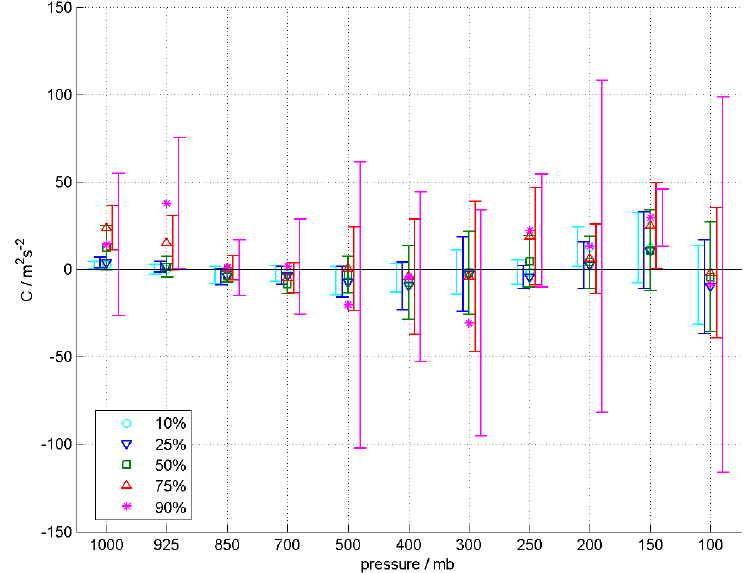
Figure 7. Results and vertical profile for the coefficient C at the five percentiles: 10%, 25%, 50%, 75%, and 90%. The error bars shown are for the 98% confidence interval.